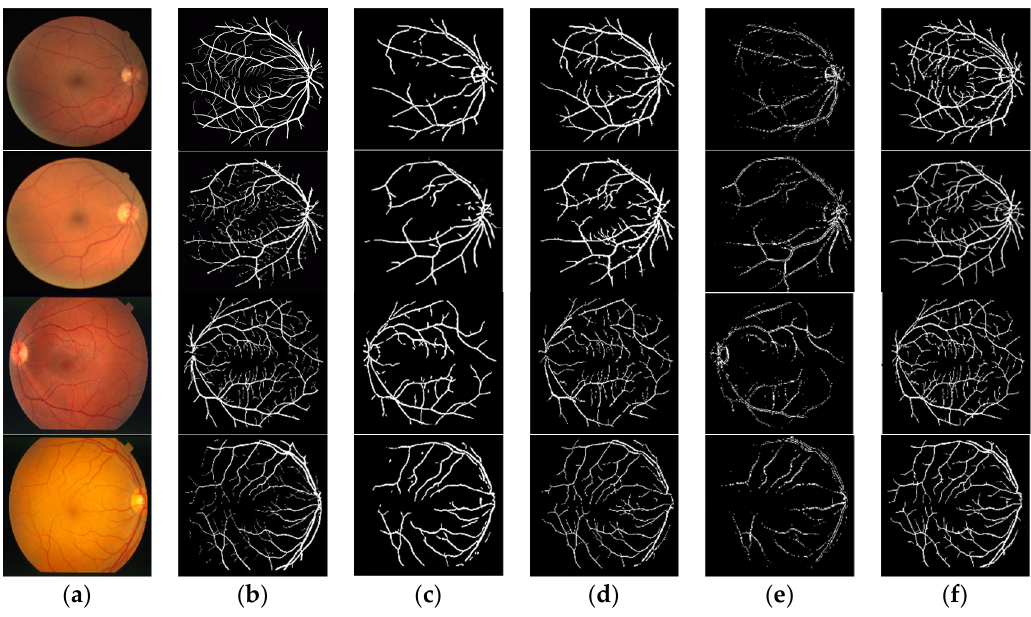
Figure 8. Blood vessel segmentation in retinal images using the proposed method. ( a ) Original im- age; ( b ) The second expert; ( c ) M1; ( d ) M2; ( e ) M3; ( f ) Proposed